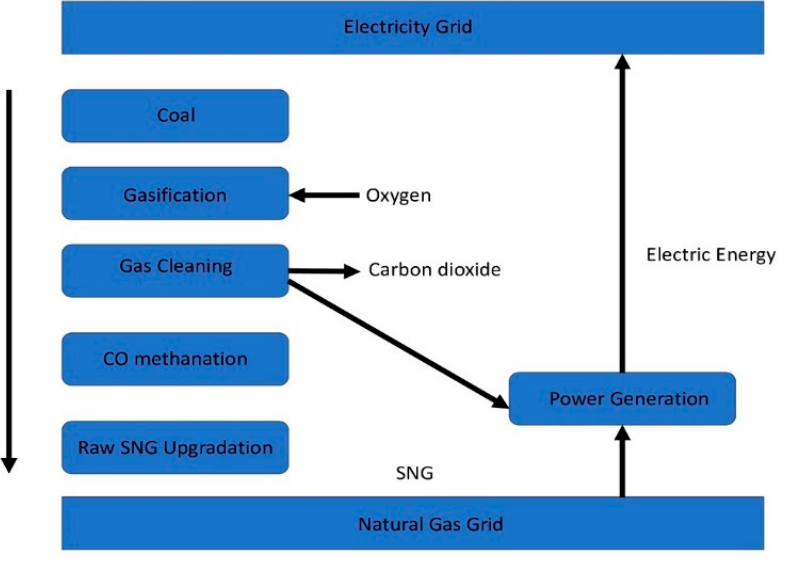
Figure 7. Flowchart of CO methanation.